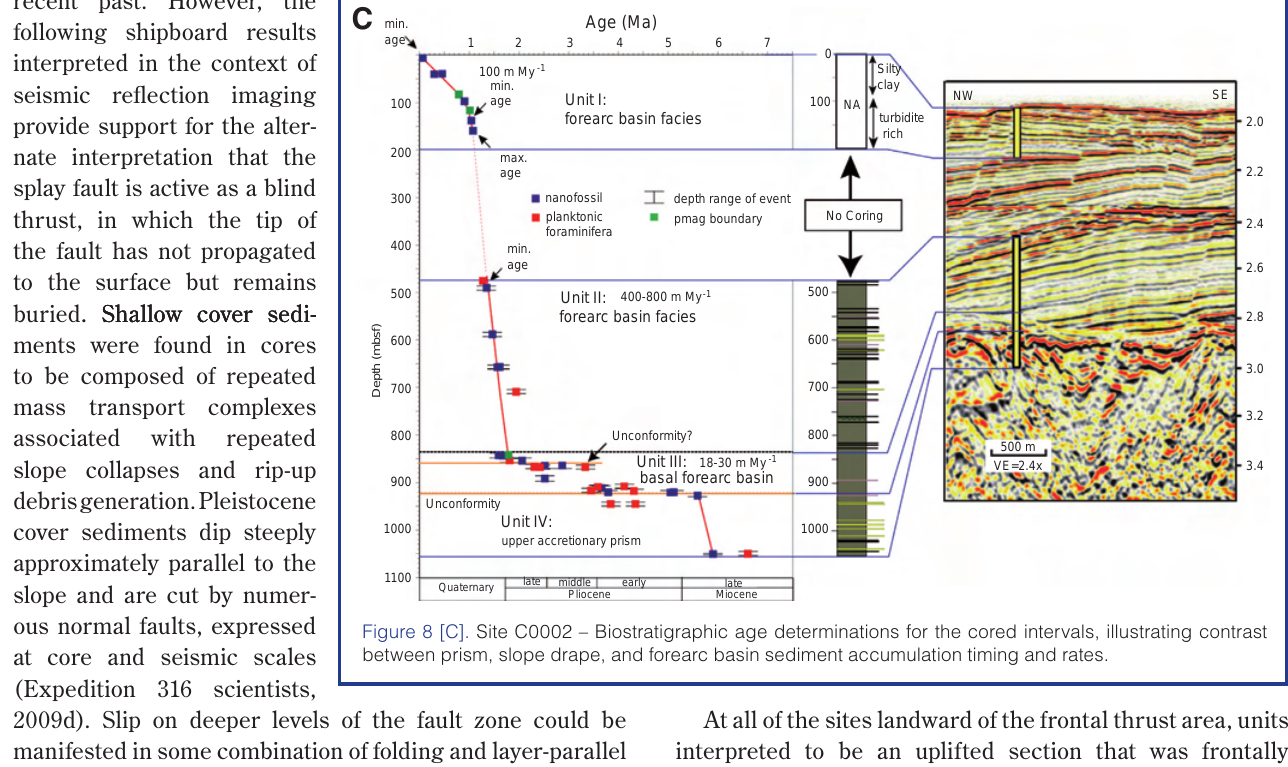
Age (Ma) min. forearc basin facies